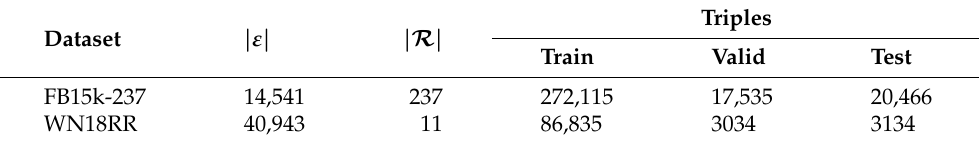
Table 4. Statistics of the datasets.